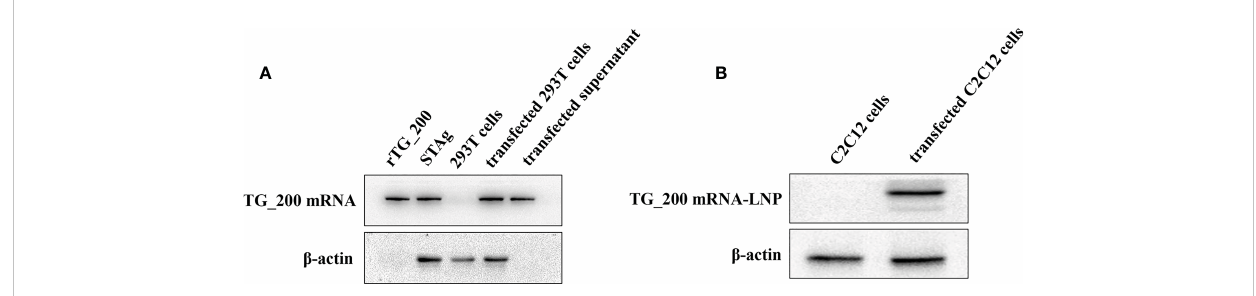
FIGURE 3 Expression of TG_200 mRNA in 293T cells and TG_200 mRNA-LNP in C2C12 cells. (A) Western blotting detection of the expression of TG_200 protein in rTG_200, STAg, 293T cell lysates and TG_200 mRNA transfected 293T cells supernatant. rTG_200: the recombinant pET28a-TG_200 acting as a positive control; STAg: soluble antigen of T. gondii ; 293T cells; transfected 293T cells: TG_200 mRNA transfected 293T cells; transfected supernatant: TG_200 mRNA transfected 293T cell supernatant. (B) Western blotting detection of TG_200 mRNA-LNP in C2C12 cells. C2C12 cells: C2C12 cell lysates; transfected C2C12 cells: TG_200 mRNA-LNP transfected C2C12 cells